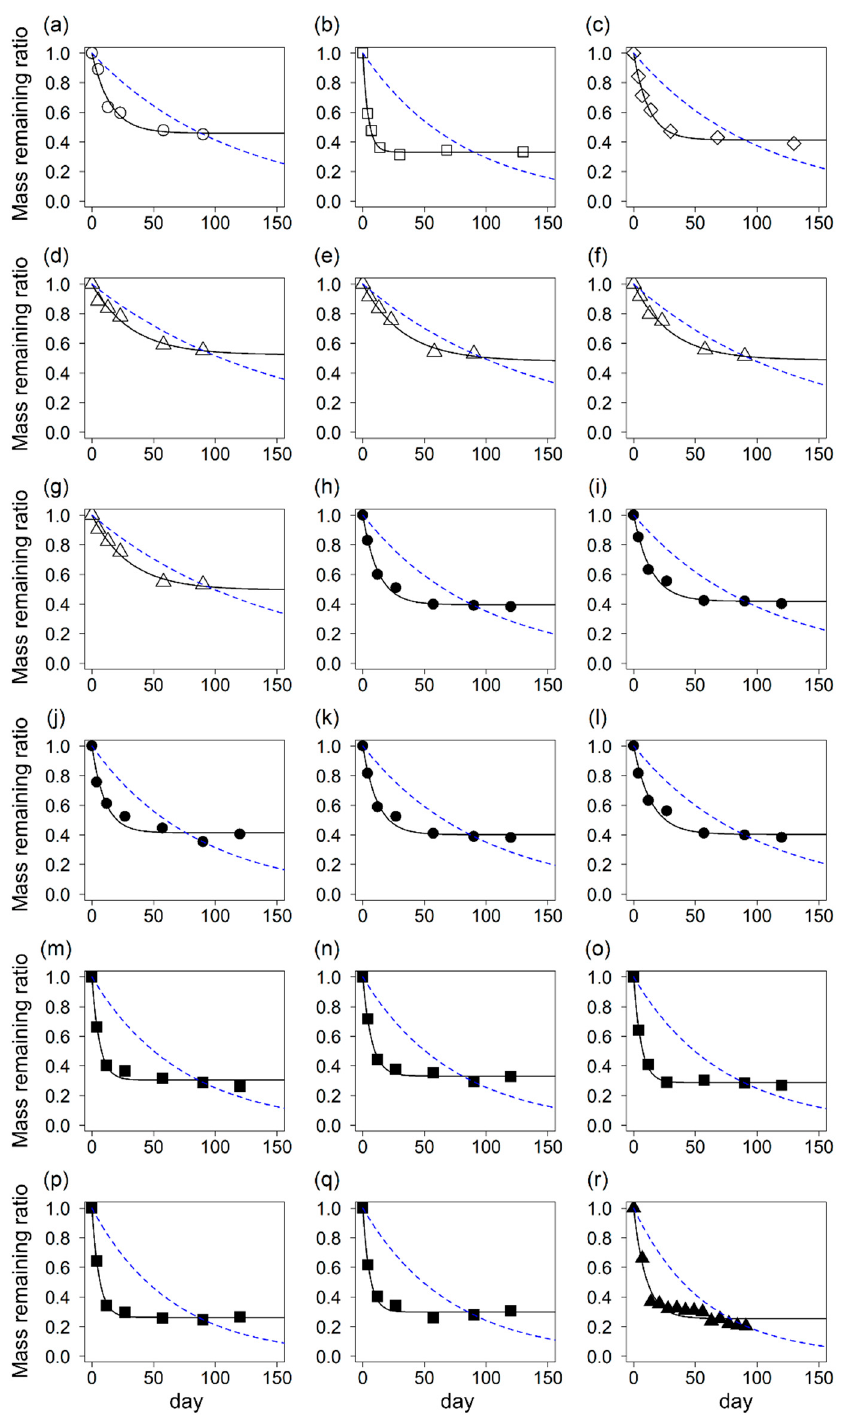
Figure 2. Mass remaining ratios of green tea during the incubation studies. Symbols in the figure indicate the proportion of green tea remaining. Different symbol indicates different incubation condition (such as soil type and incubated temperature). Black lines indicate the fit to the asymptote model. Dashed blue lines indicate the single exponential model describing green tea decomposition. Data were obtained from the present incubation study ( a ), Keuskamp et al. (2013) [2] ( b , c ), Mori (2022) [7] ( d – g ), Mori (2022) [11] ( h – q ), and Duddigan et al. (2020) [10] ( r ). Data points in figures b , c , and r indicate mean values.